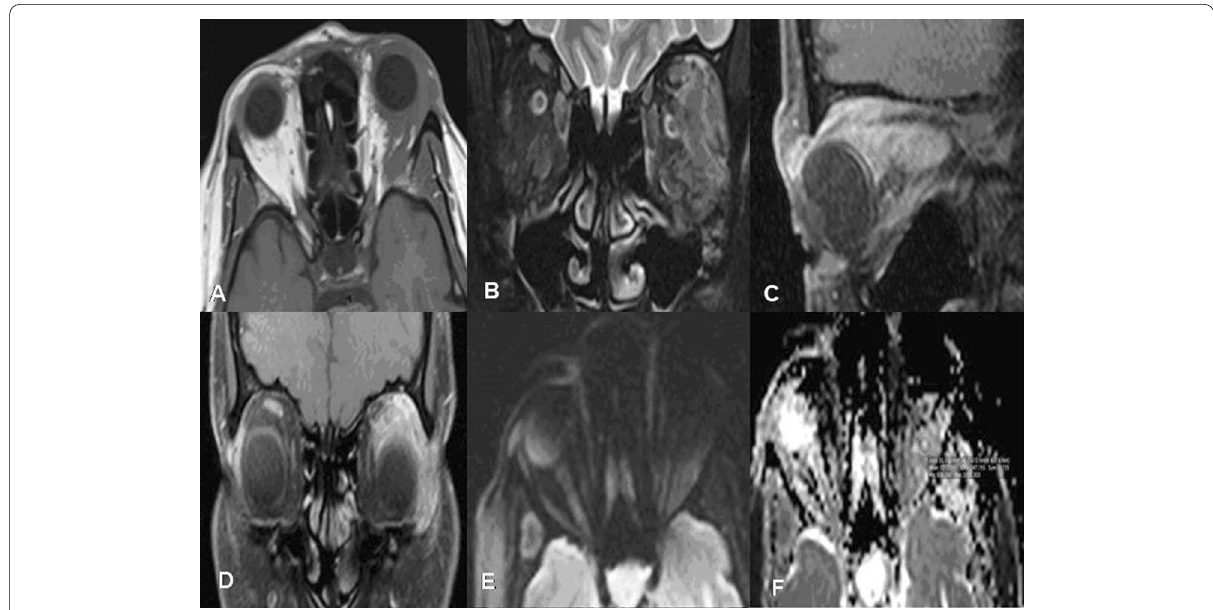
Fig. 2 A 56-year-old male with acute sinusitis presented with left-sided orbital pain and blurring of vision. Axial T1-weighted image A shows hypointense signal involving the sclera of left eye, the related intra- and extraconal fat planes and the lateral rectus muscle. Coronal T2-weighted image B shows an extraconal mass involving the left lateral rectus muscle, the lacrimal gland with intraconal extension. Post-contrast T1 fat-saturated images C , D show homogeneous enhancement of the extraconal mass and its intraconal component. No diffusion-weighted restriction seen on DWI (b 500 ) ( E ) and ADC (F) . The ADC value for the lesion is 1.27 10 − 3 mm 2 / sec. FNAC of the mass proved to be left-sided × orbital inflammatory pseudotumor